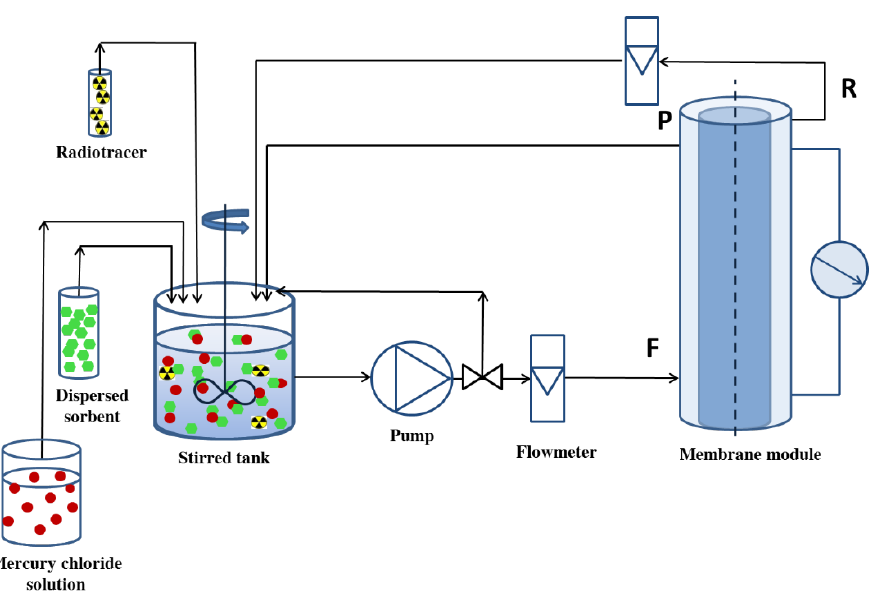
Figure 4. Experimental set-up used for sorption-assisted microfiltration experiments.